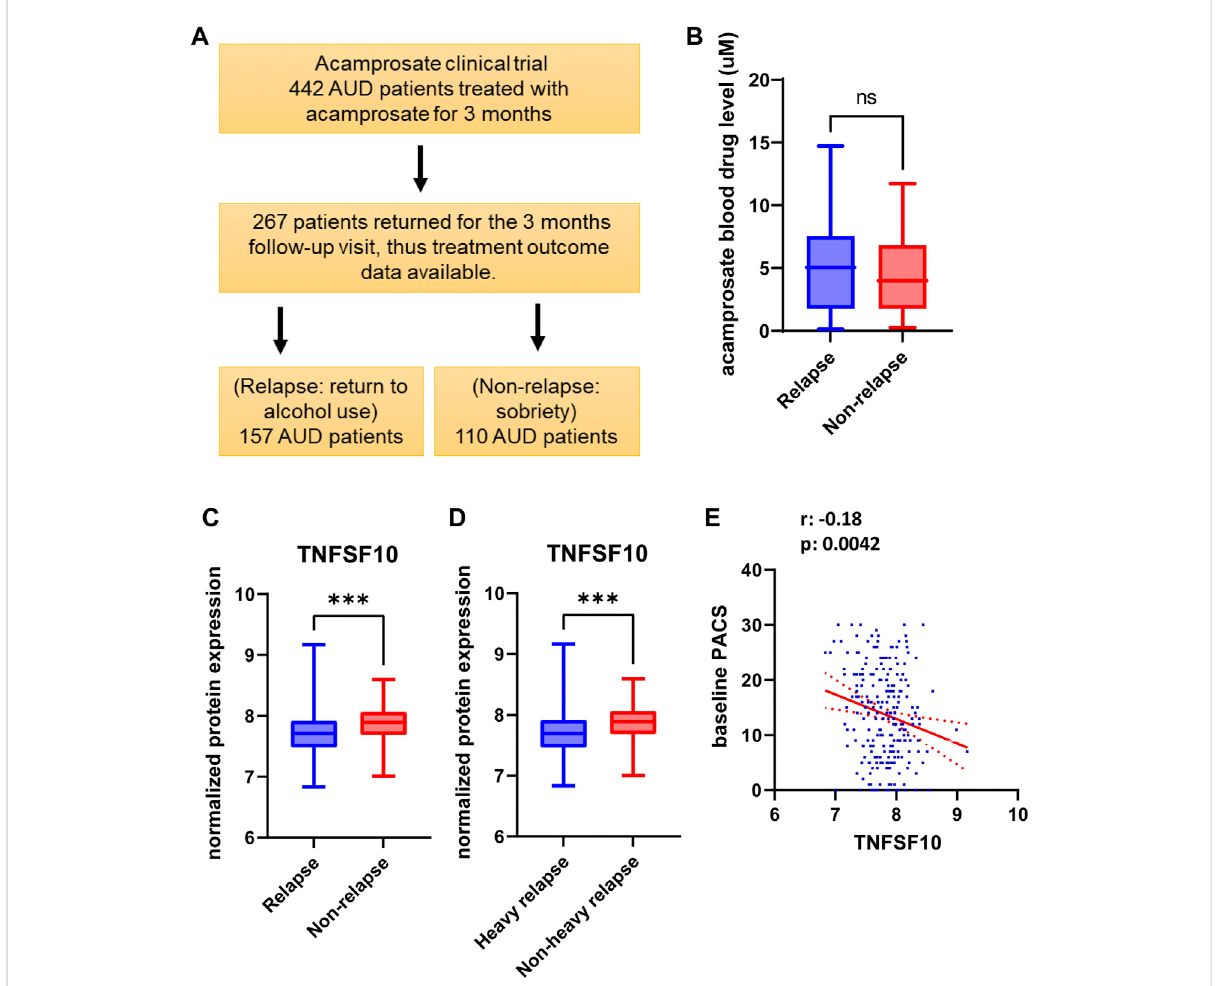
FIGURE 1 (A) Study design and sample numbers for the acamprosate clinical trial. (B) Blood concentrations of acamprosate in relapse and non-relapse groups. (C) LowerbaselineplasmaTNFSF10concentrationswereobservedinAUDpatientswhorelapsedduring3 monthsofacamprosatetreatment ( t = 3.658, df = 243, ***p:0.0003). Relapse was de fi ned as taking one drink during 3 months of acamprosate treatment, while non-relapse was de fi ned as remaining abstinent during 3 months of acamprosate treatment. (D) Lower baseline plasma TNFSF10 concentrations were